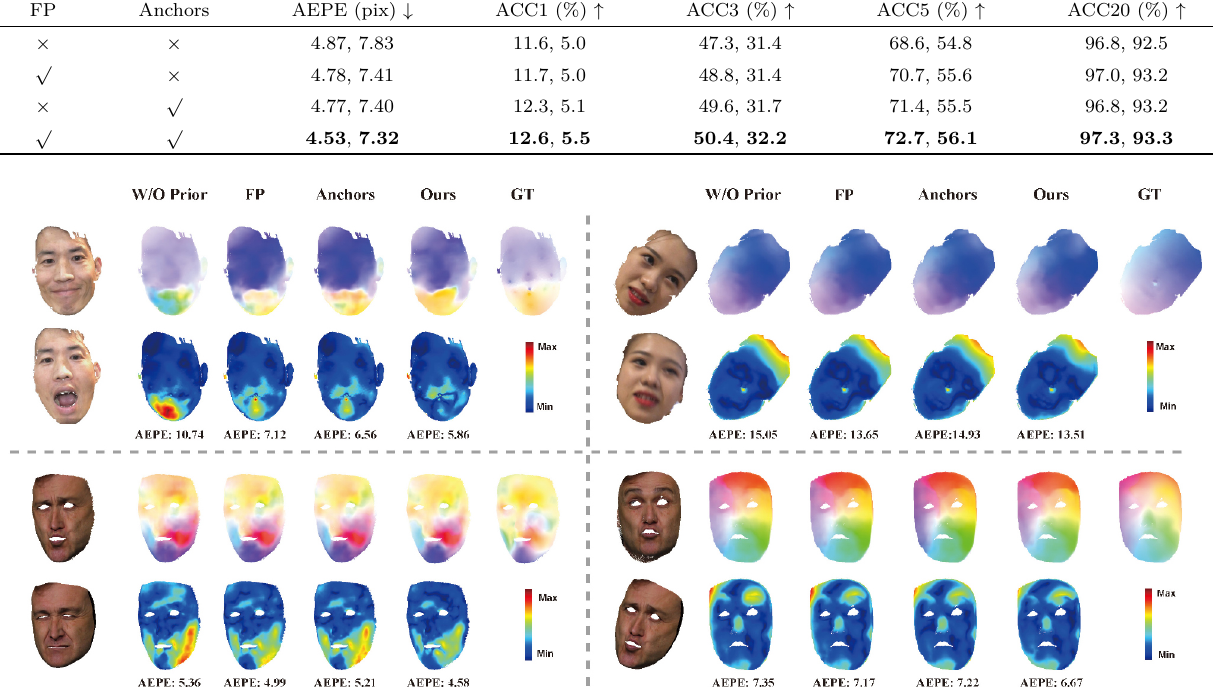
Table 1 Ablation study on the Synthetic Face and FaceFlowData datasets. FP: results utilizing face parsing priors during training. Anchors: results introducing 3D reconstruction and landmarks as anchors to assist the differentiable non-rigid alignment. Results for the Synthetic Face and FaceFlowData datasets are separated by commas. Best results are in bold